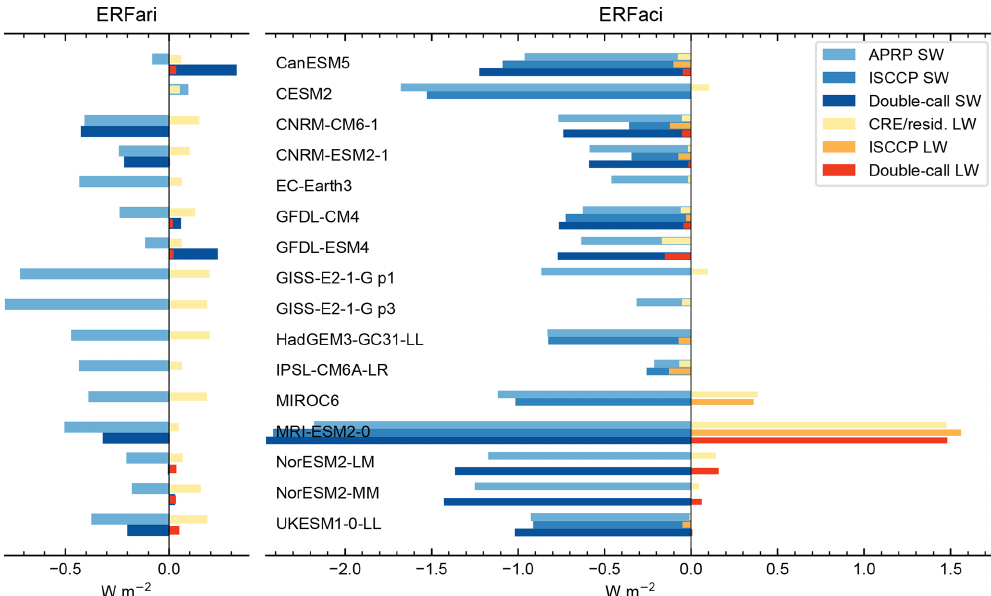
Figure 11. Comparison of methods to estimate ERFaci and ERFari from the aerosol experiment. CRE/resid. (residual) is the LW cloud radiative effect for ERFaci and the difference of LW ERF and CRE for ERFari. Not all methods are available in all models. Table 7. As for Table 3 but for 1850–2014 land use forcing.